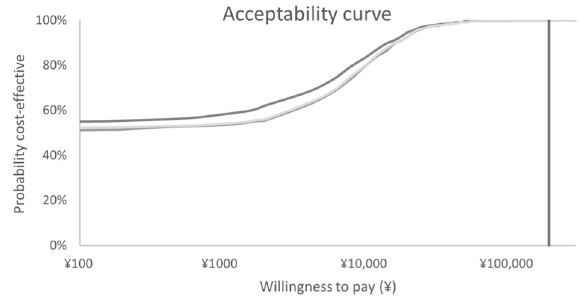
Fig. 2 Acceptability curve. Cost-effectiveness acceptability curve in term of QALYs for Portable spirometer and questionnaire screening strategies versus no screening (usual care) in probability sensitivity analysis. Note: the x -axis was based on logarithm scale for better convenience to